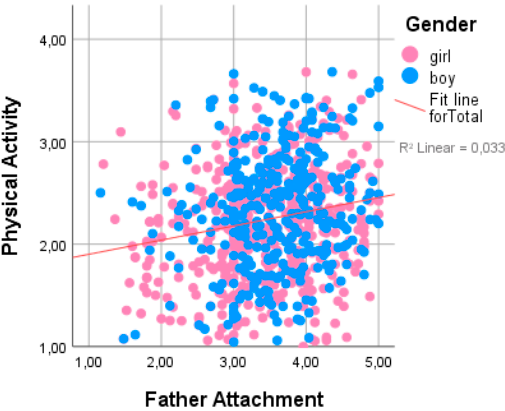
Figure 1. Interrelationships among PA, adolescent gender, and overall father attachment scale.